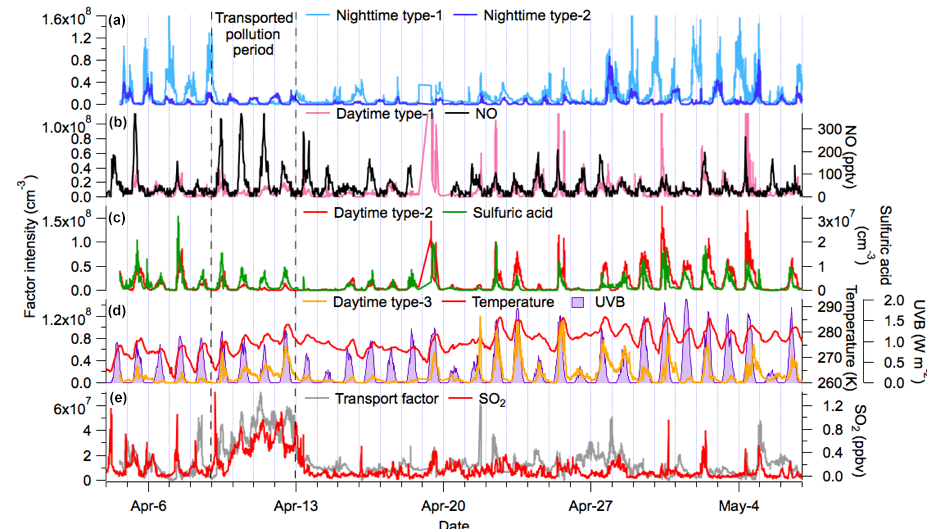
Figure 10. Temporal behaviors of PMF factors and relevant tracer gases as well as meteorological conditions. The period with transported pollution is marked by the dashed lines. Panel (a) depicts the temporal variation of the two nighttime factors. Panel (b) shows the time series of daytime type-1 factor together with NO. Panel (c) demonstrates the similar temporal behavior of the daytime type-2 factor and sulfuric acid. Panel (d) shows the time series of the daytime type-3 factor together with the relevant meteorological conditions (i.e., UVB and temperature). Panel (e) depicts the temporal variation of the transport factor, together with SO 2 , a tracer for transported